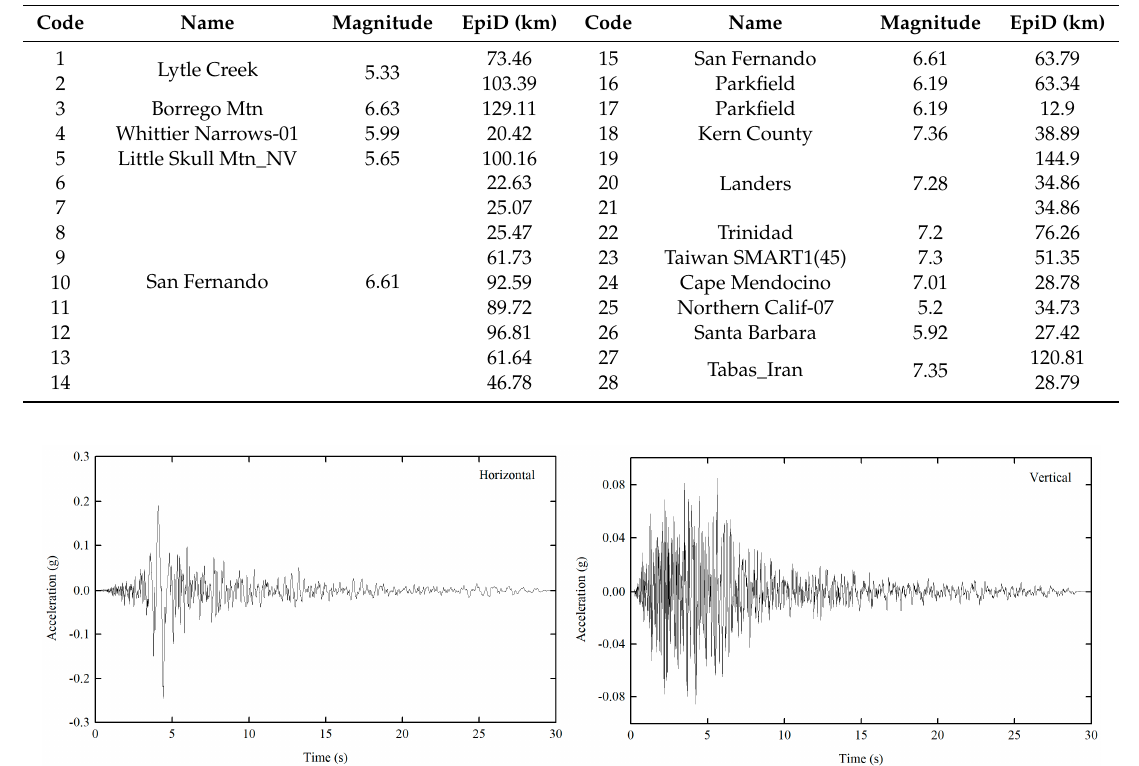
Table 3. Earthquake waves.